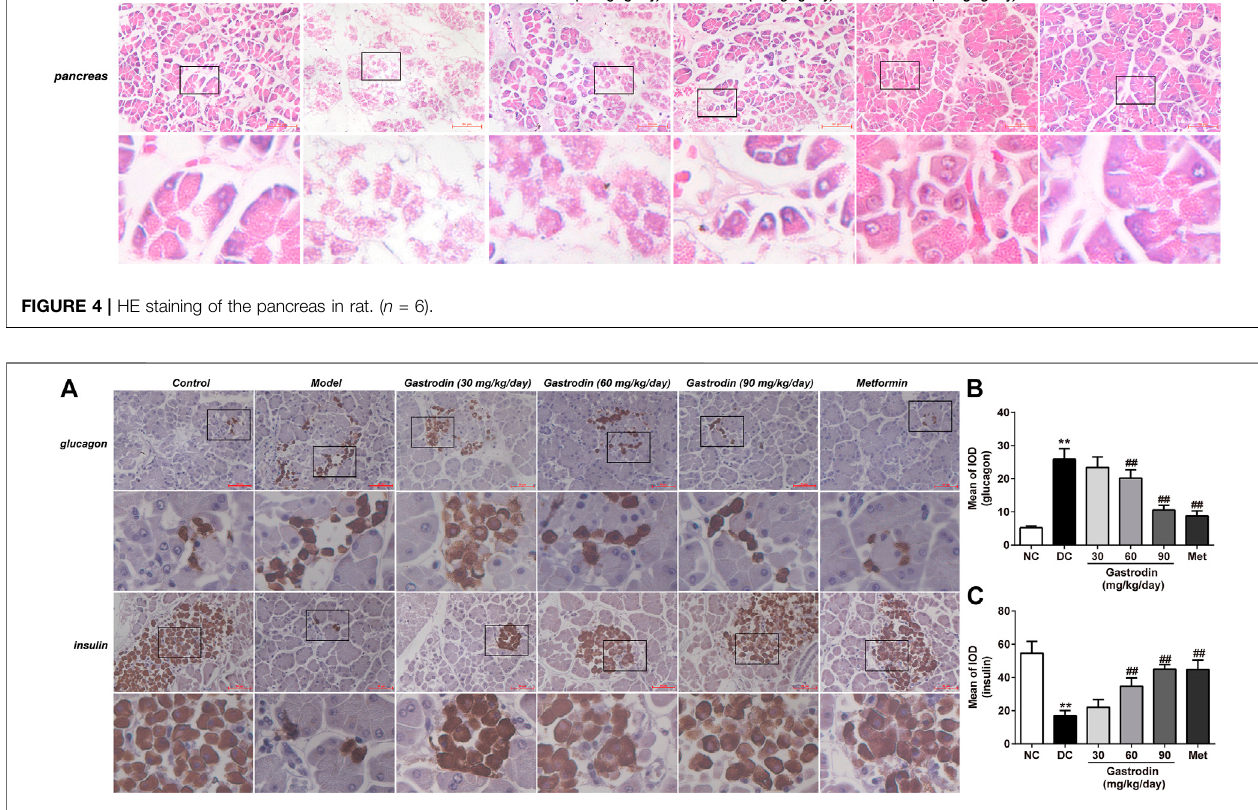
FIGURE 5 | Glucagon and insulin staining of the pancreas tissues in rat. The results were presented as mean ± SD ( n (cid:1) 6). ** p < 0.01, vs. NC group, # p < 0.05, ## p < 0.01, vs. DC group.